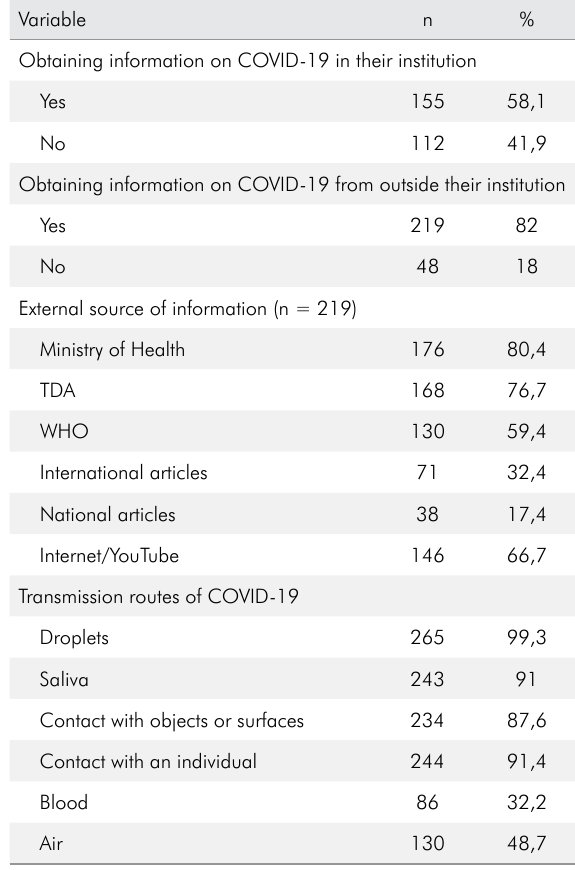
Table 3. Responses according to the information obtained about COVID-19, source of information, and transmission routes of